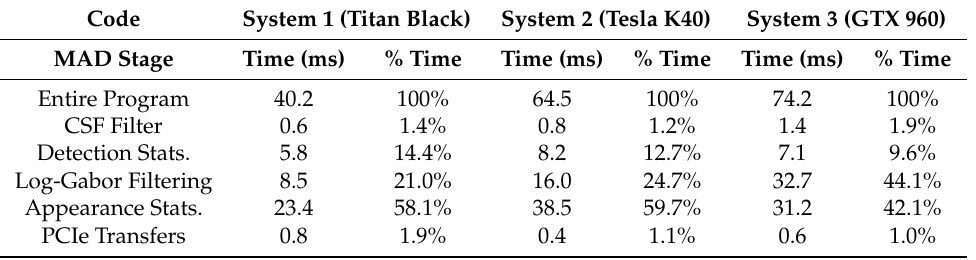
Table 6. Results on systems with different